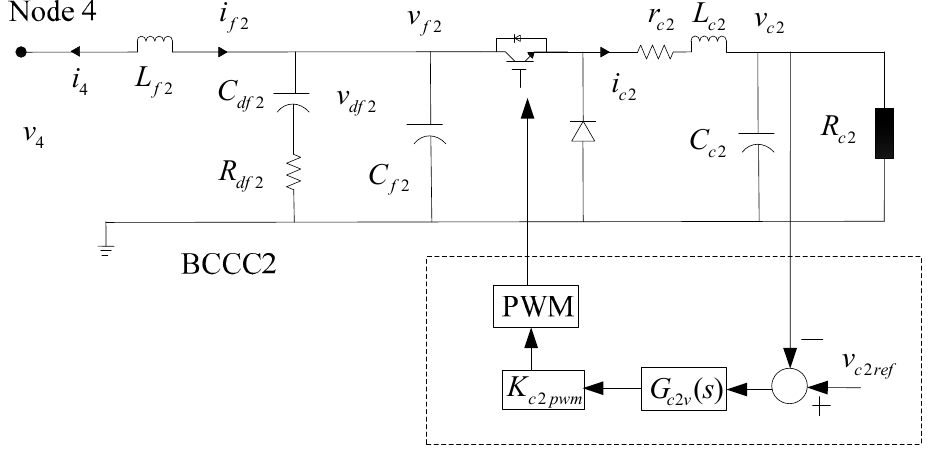
Figure 3. The close-loop circuit of the constant power load (CPL) with an electromagnetic interference (EMI) filter.